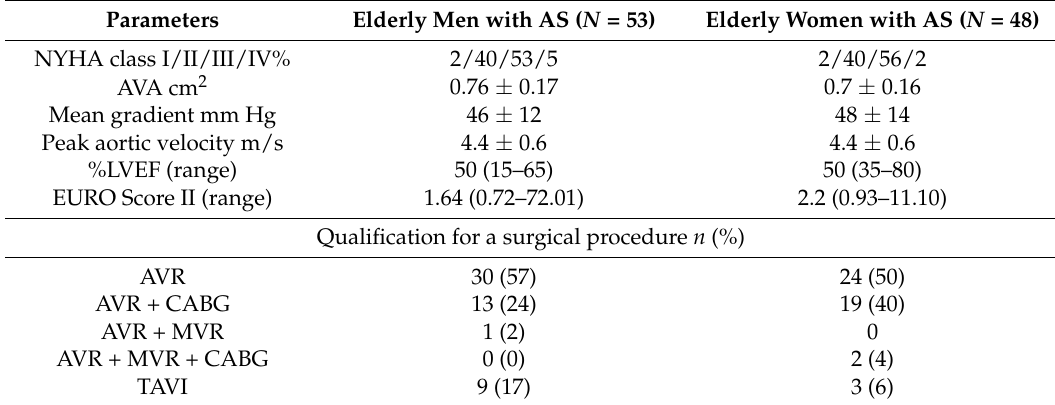
Table 1. Characteristics of patients with aortic stenosis. Data are presented as mean ± SD/range.